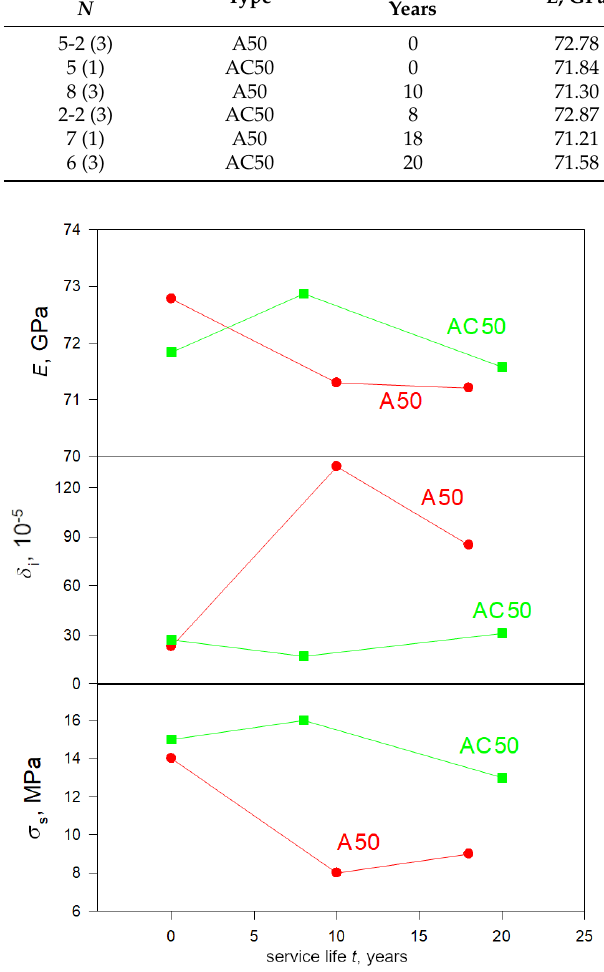
Figure 22. Dependences of Young’s modulus E , amplitude-independent decrement δ i , and microplastic stress σ s for Al wires on operating time t . The measurements were taken at room temperature.